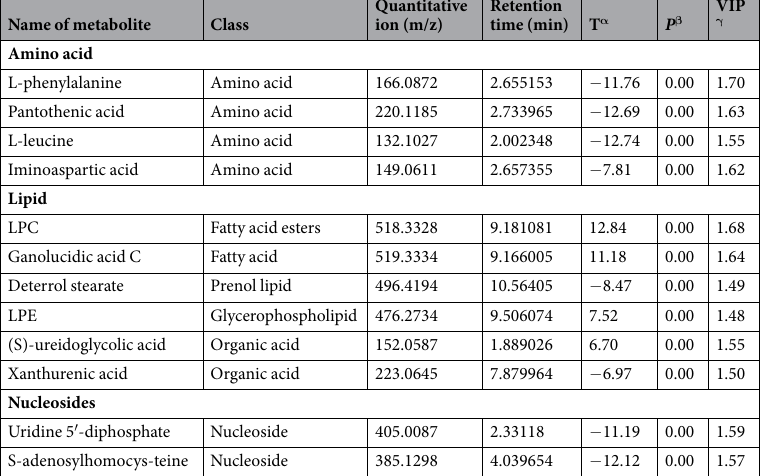
be obtained at higher capacities. Therefore, to improve the mycelial growth of I . farinosa , high capacities should be paired with high rotation speeds. However, this hypothesis needs further testing. During the mass industrial production of fungi, the amount of inoculum concentration is an important crite- rion that not only decides the output of the submerged fungi but also contributes to the final cost. Here, 10% was regarded as the best inoculum concentration, which was same as the concentration reported by Ze et al . 28 for I . farinosa . Illumination affects the growth and development of fungi. Arjona et al . 29 reported that the mycelial growth of Pleurotus ostreatus (Jacq.) P. Kumm. 1871 was inhibited by white light. Additionally, blue light prevented the mycelial growth of Monascus ruber Tiegh. 1884 30 and Cordyceps militaris (L.) Fr. 1818 31 . Illumination prevented the